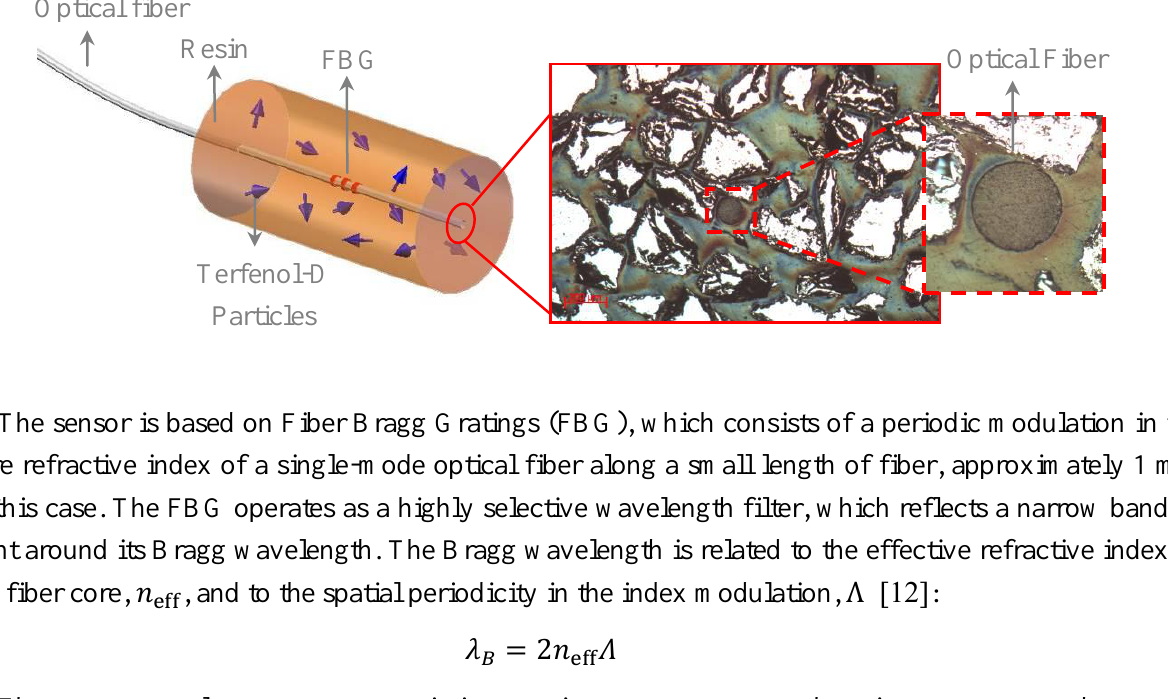
Figure 4. Schematic configuration of the magnetostrictive composite FBG sensor; the cross section micrograph in the inset shows Terfenol-D particles and the optical